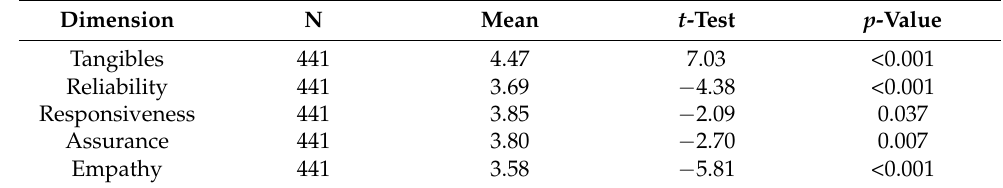
Table 7. One-sample t -test results for comparing SERVQUAL dimensions to the neutral value. Dimension